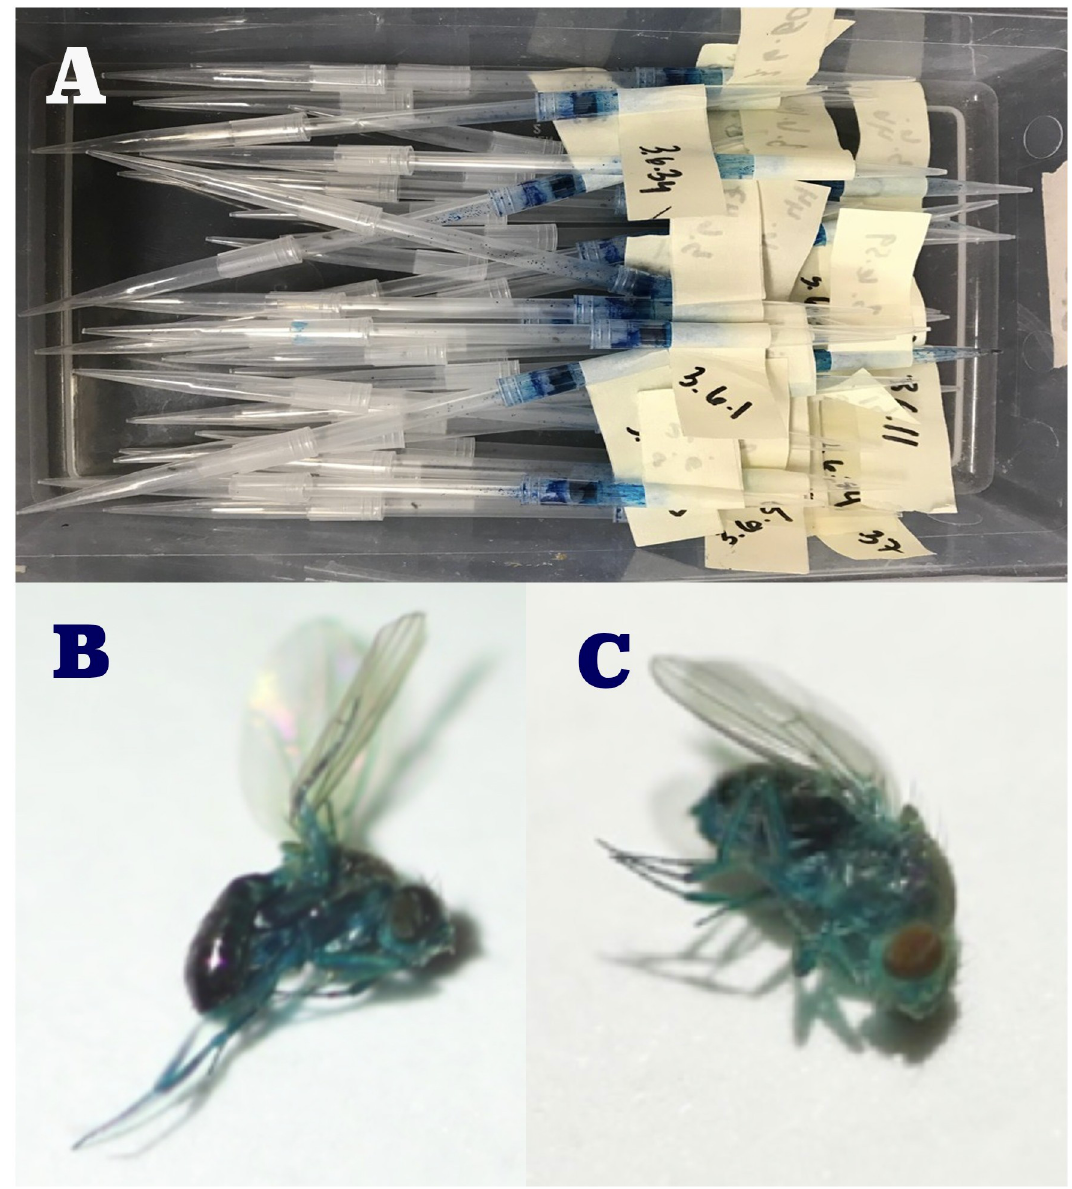
Fig 1. A. Adult, 14 day old (from egg) flies were placed into individual plastic straws about 4 inches in length and capped with plastic pipette tips on both ends. Each straw was labeled with a number that allowed us to keep track of each fly, B. Blue male Smurf at the time of death, C. Blue female Smurf at time of death. The head, thorax and abdomen have all visibly become blue for both the male and female D . melanogaster